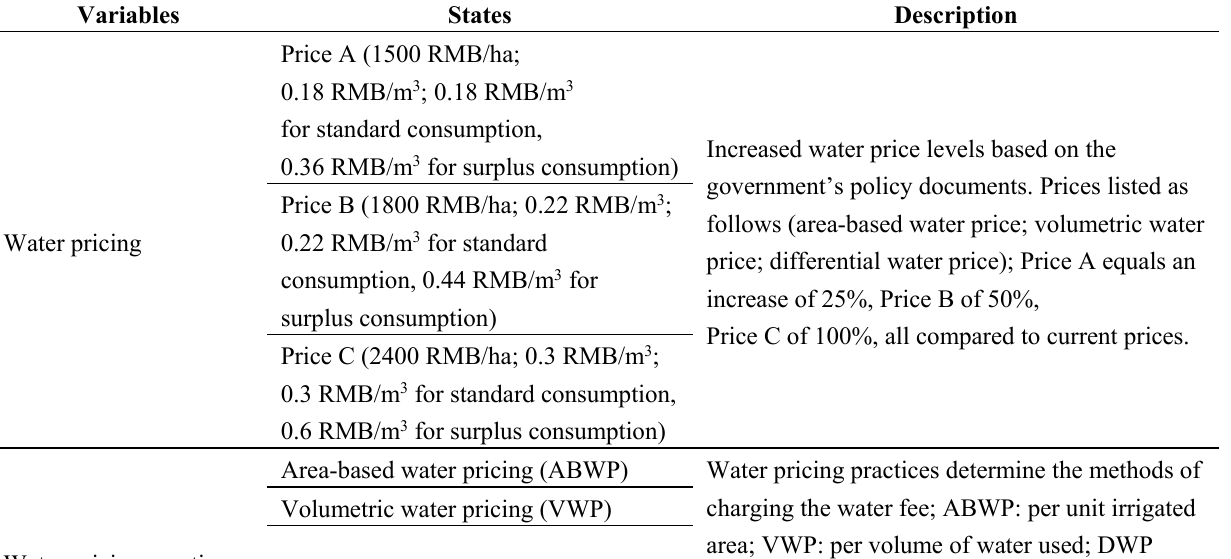
Table 2. Variables, variable states, and detailed description of the variables in the Bayesian networks (1 RMB = 0.16